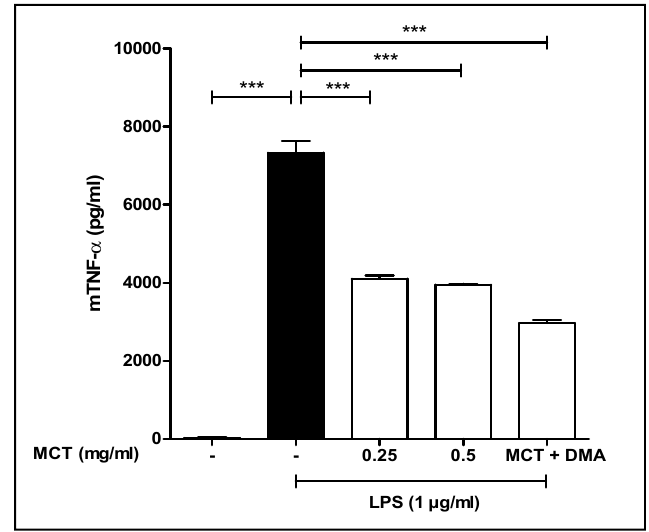
Figure 4. Effect of medium chain triglyceride (MCT) and MCT + DMA on LPS-stimulated TNF- α secretion from RAW 264.7 cells. MCT at 0.25 and 0.5 mg/mL reduced TNF- α secretion by 46% and 50%, respectively. The combination of MCT + DMA reduced TNF- α secretion by 60%. (*** p < 0.001, ANOVA).